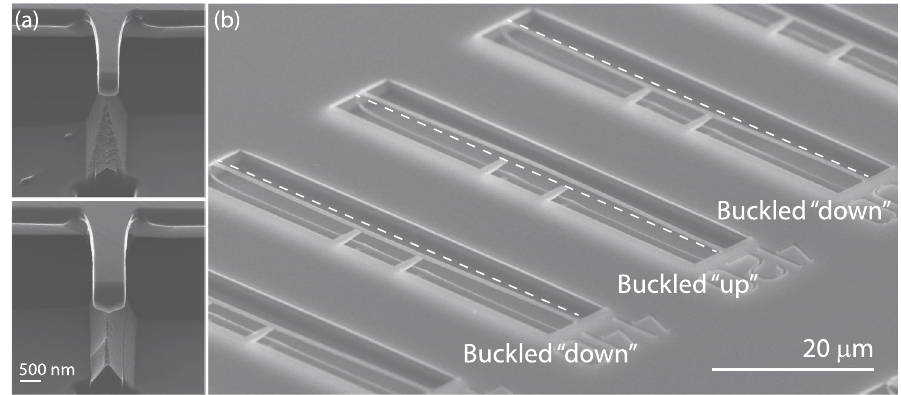
FIG. 6. (a) Nanobeam cross sections, created by focused ion beam (FIB) milling, of two nanobeams with different w patterned on the same chip. Note that the FIB milling process rounds the nanobeam edges, resulting in some apparent curvature in the nanobeam profiles. (b) SEM image of typical nanobeams observed to self-oscillate. Dashed straight lines are guides to emphasize the direction of nanobeam